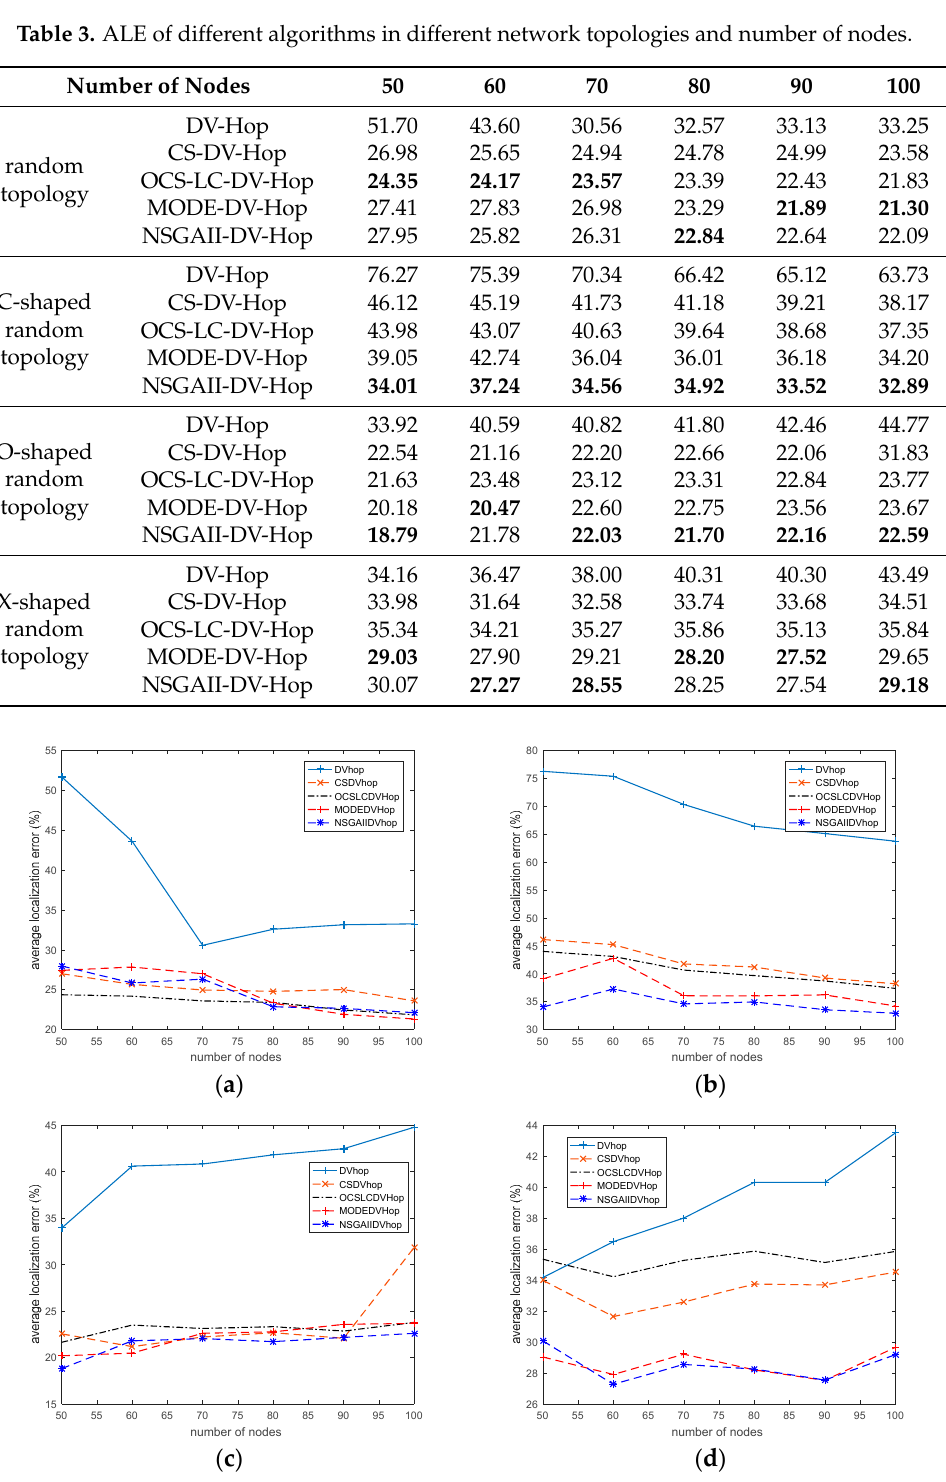
Figure 10. The ALE of four network topologies in different number of nodes. ( a ) The random topology; ( b ) The C-shaped random topology; ( c ) The O-shaped random topology; ( d ) The X-shaped random topology.